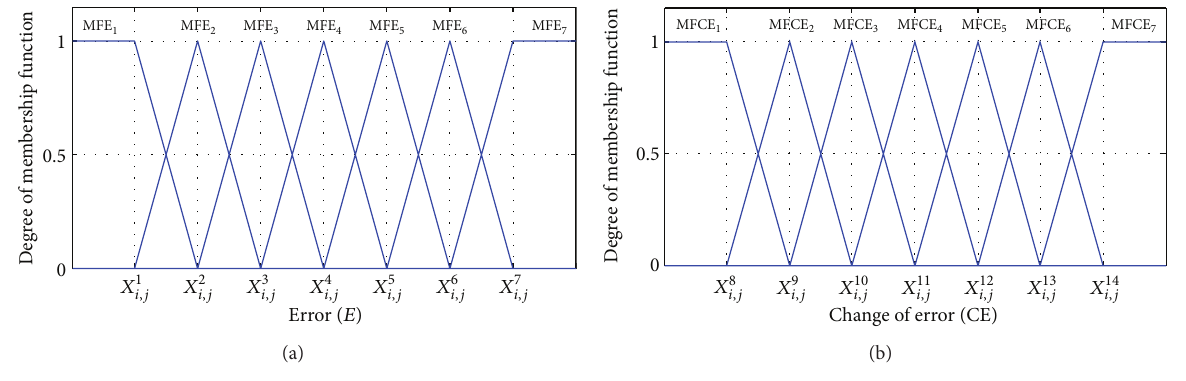
Figure 9: FLC with 7 MFs for (a) 𝐸 and (b)